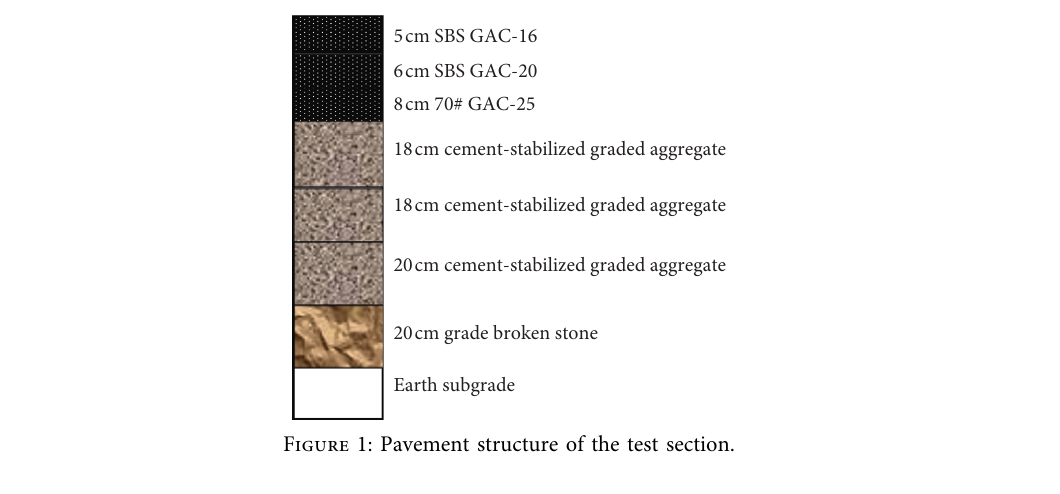
Table 2: Test results of the coarse aggregate technical indicators.